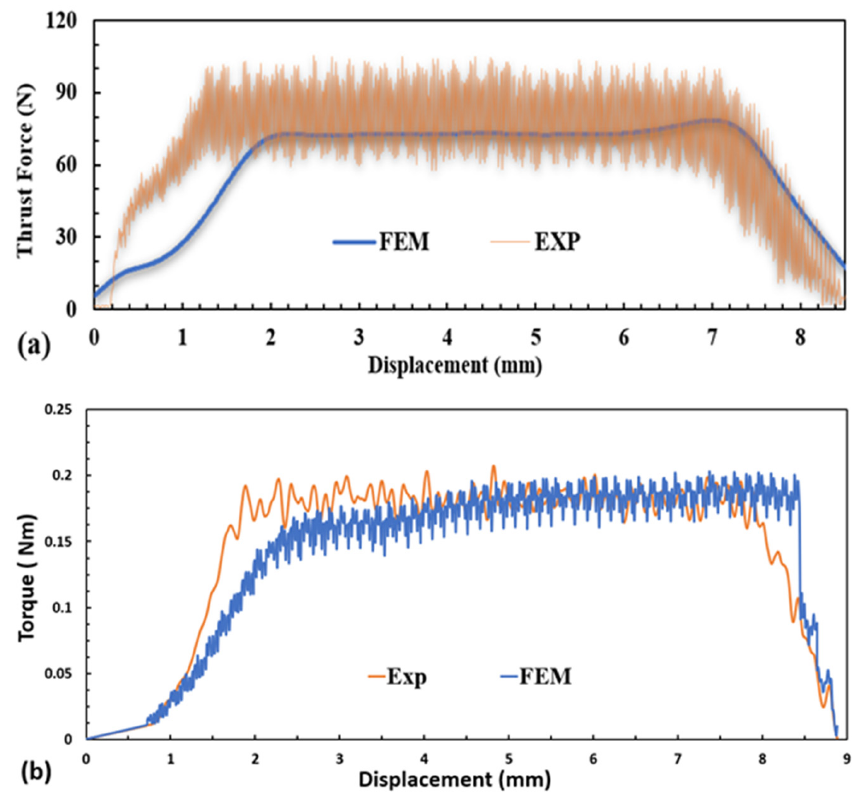
Figure 3. Comparison between FEM prediction and experimental results at a spindle speed of 3000 rpm and feed rate of 5 mm/s: ( a ) thrust force comparison and ( b ) torque profiles.